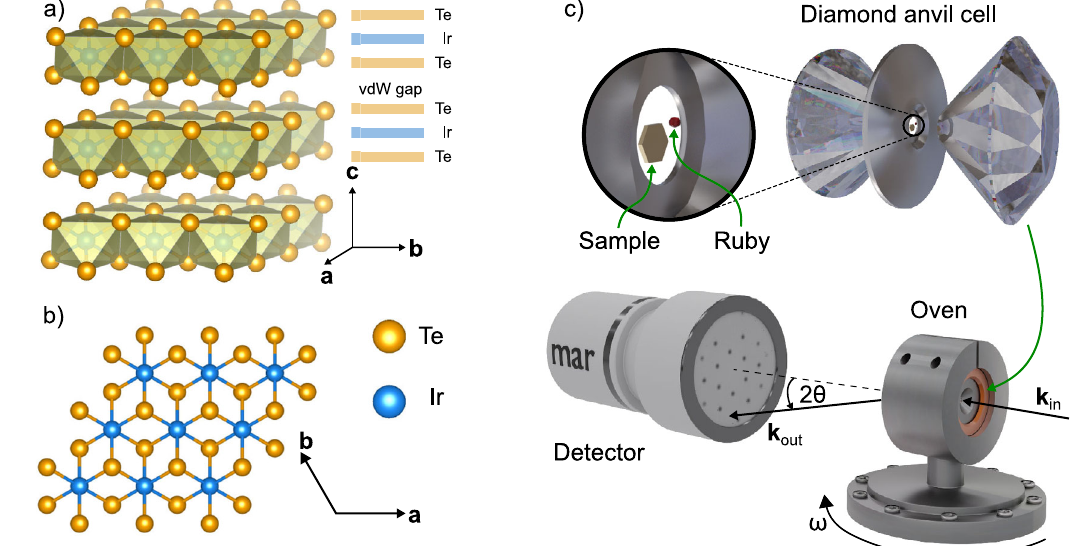
Fig. 1 Host crystal structure of IrTe 2 and experimental setup. a Side view of the trigonal 1 T (spacegroup: 164) host crystal structure of IrTe 2 . The layered structure of IrTe 2 with a van der Waals gap in between Te-Ir-Te layers is illustrated on the right. b Top view of the host crystal structure of IrTe 2 ( a , b , and c indicate the lattice vectors). c High-pressure x-ray diffraction setup at the beamline ID27 at the European Synchrotron Radiation Facility (ESRF). The sample is placed in a diamond anvil cell mounted in an oven which can be rotated around ω . k in and k out are the wave vectors of the incoming and scattered photons, respectively. 2 Θ is the scattering